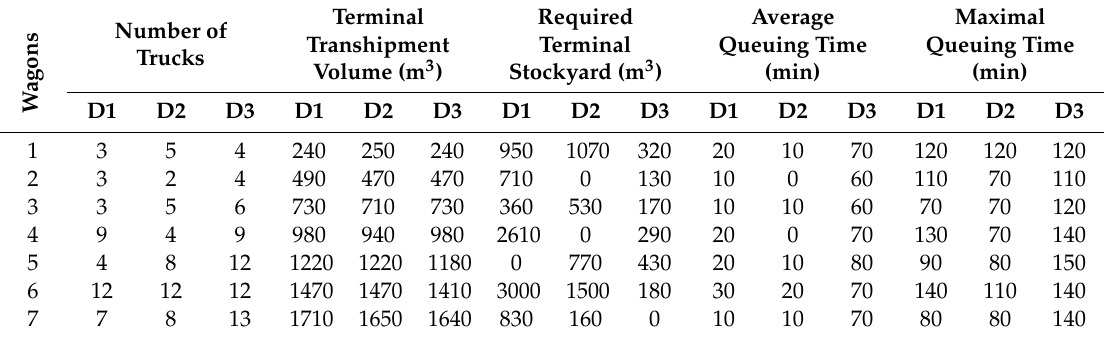
Table4. BestperformingsimulationresultsforstrategyMAXVOLUME(maximalterminaltranshipment volume) for one train pick-up.